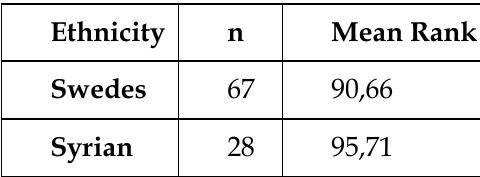
Table 6. Concern about breaching privacy and ethnicity. Kruskal-Wallis mean